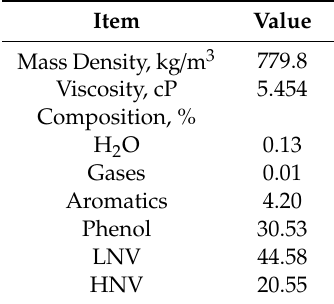
Figure 2. Reaction networks for pyrolytic oil upgrading. Table 1. Properties of pyrolytic oil.